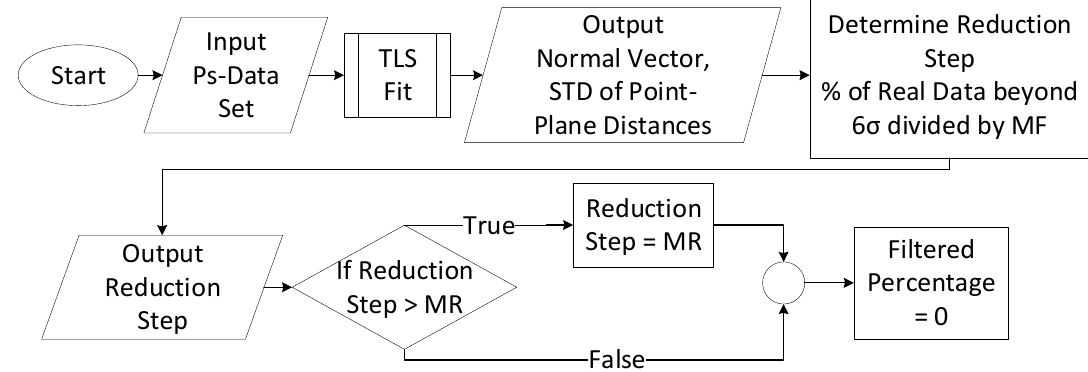
Figure 2. Data initialization process with point dataset (Ps).